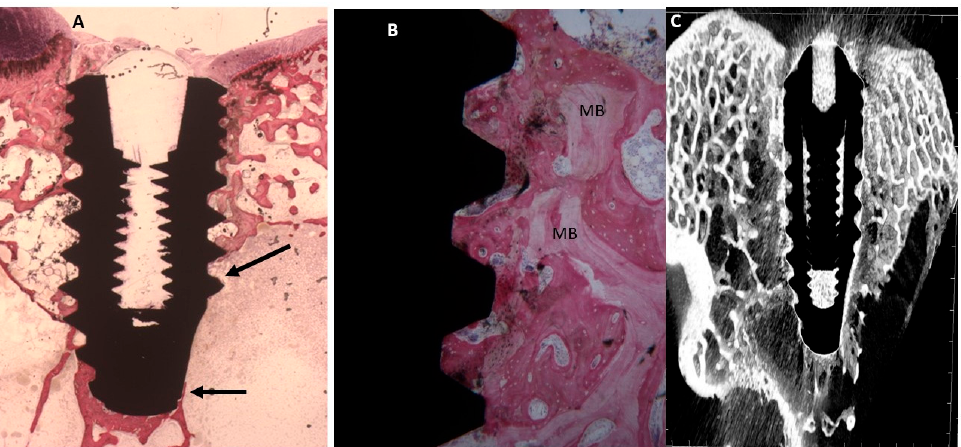
Figure 7. (A ) A thin layer of mature bone was present around the fixture. Toluidine blue and acid fuchsin staining 2 × . ( B ) At higher magnification, a remodeling mature bone (MB) was evident around the implant surface (Arrows). Toluidine blue and acid fuchsin staining 50 × . ( C ) Micro-CT scans along transection planes of the dental implant. Trabecular bone was present in contact with the dental implant.